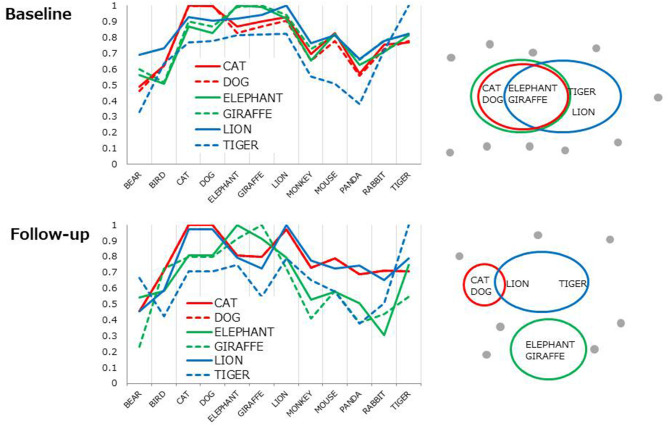
Cosine profiles for the most frequent six items. Each line represents 6D cosine values between one of the six items and the other frequent 12 items. The profile patterns are conceptually illustrated as from of clusters (right).